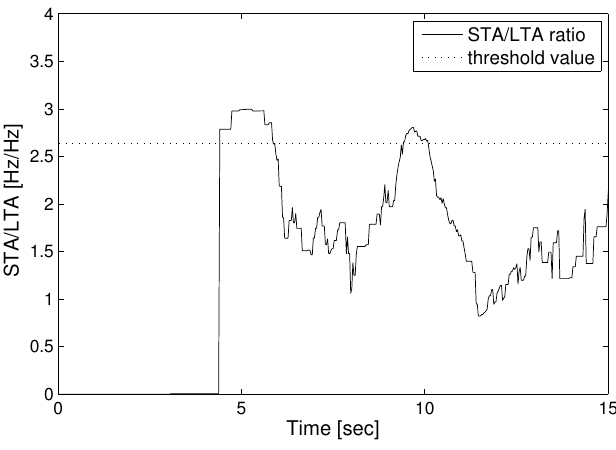
Figure 8. Estimation of the STA/LTA ratio.